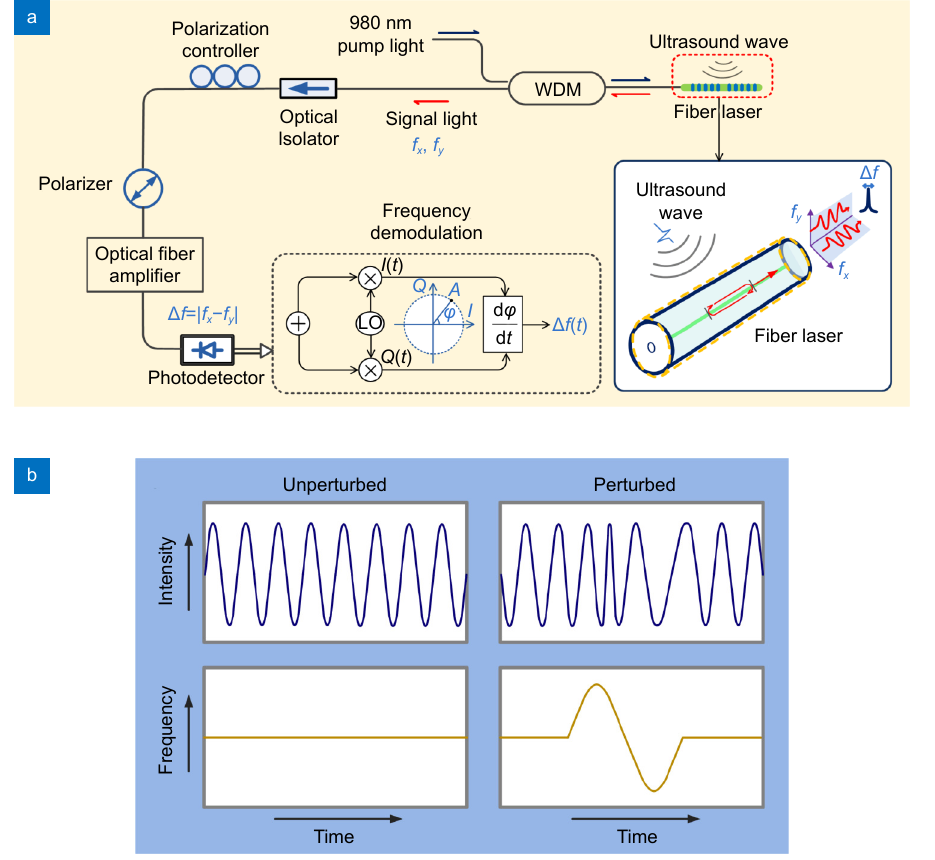
Fig. 3 | ( a ) Schematic of ultrasound detection by using a fiber-laser sensor. ( b ) Unperturbed and ultrasonically perturbed beat signal output from the sensor. Figure reproduced with permission from ref. 30 , under a Creative Commons Attribution 4.0 International